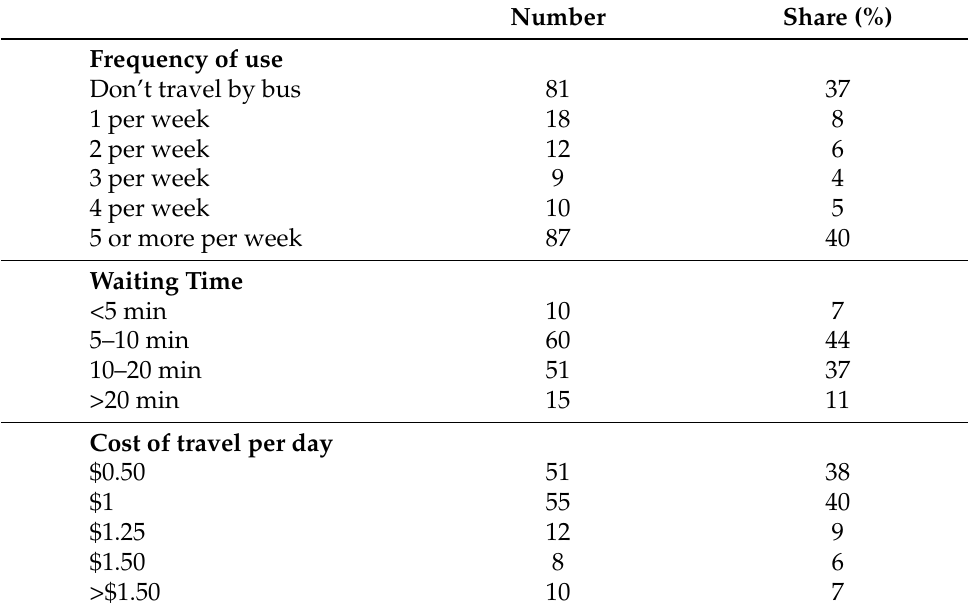
Table 2. Demographic summary of the bus users.